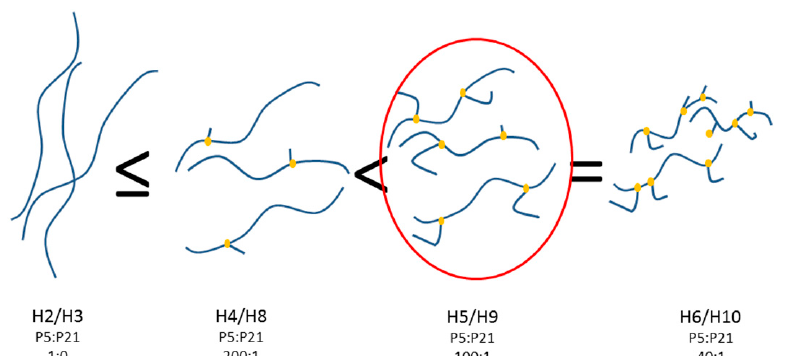
Figure 7. TEM images of diluted samples of hydrogel H4 ( a ), H5 ( b ), and H6 ( c ). Scale bar repre- sents 500 nm.